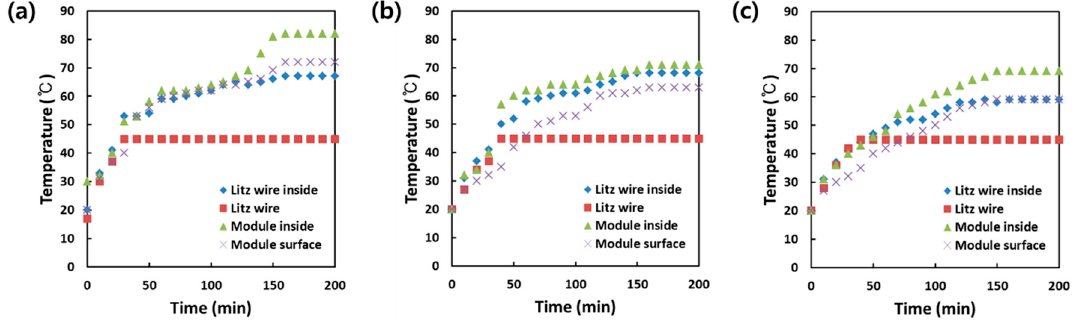
Figure 5. Experimental results of temperature measurement for three candidates: ( a ) Module A, ( b ) module B, and ( c ) module C.